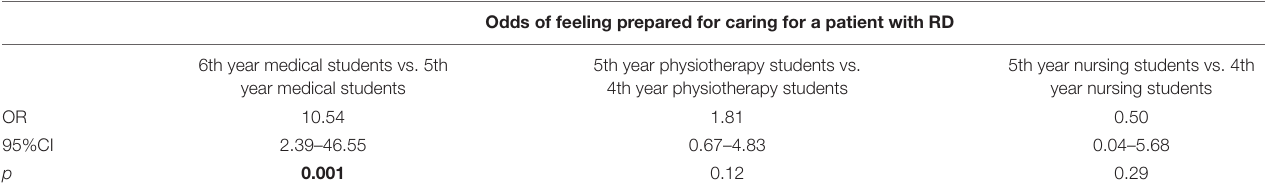
TABLE 7 | The odds ratio of feeling prepared for caring for a patient with RD for students during the final 2 years of study. Odds of feeling prepared for caring for a patient with